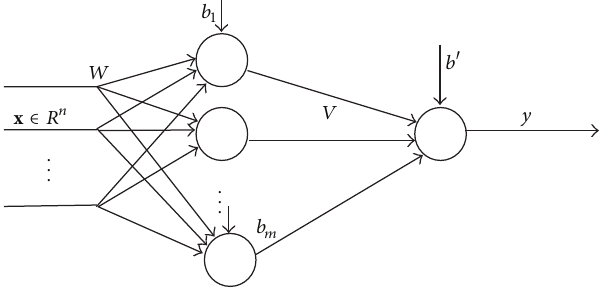
Figure 1: Multilayer Perceptrons.